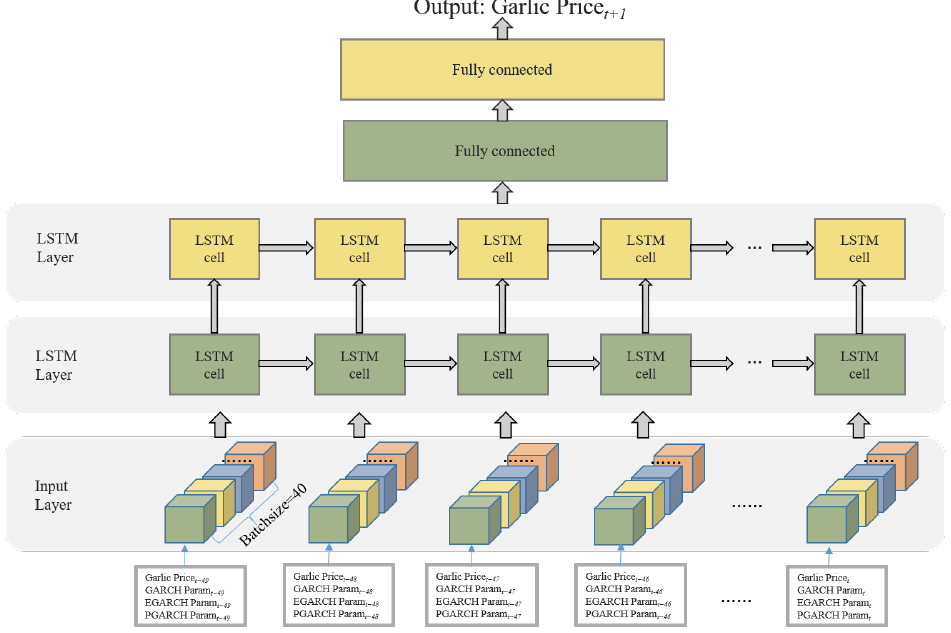
Figure 3. LSTM–GARCH structure